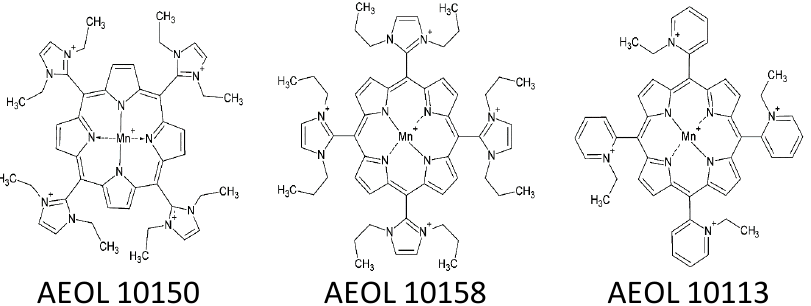
Figure 1. Cationic manganese (III) meso -porphyrin antioxidant structures. Meso -porphyrins were originally formulated as their respective chloride salts. These original chloride salt formulations were anion exchanged with thiocyanate ( − SCN) to generate their respective − SCN salt formulations.